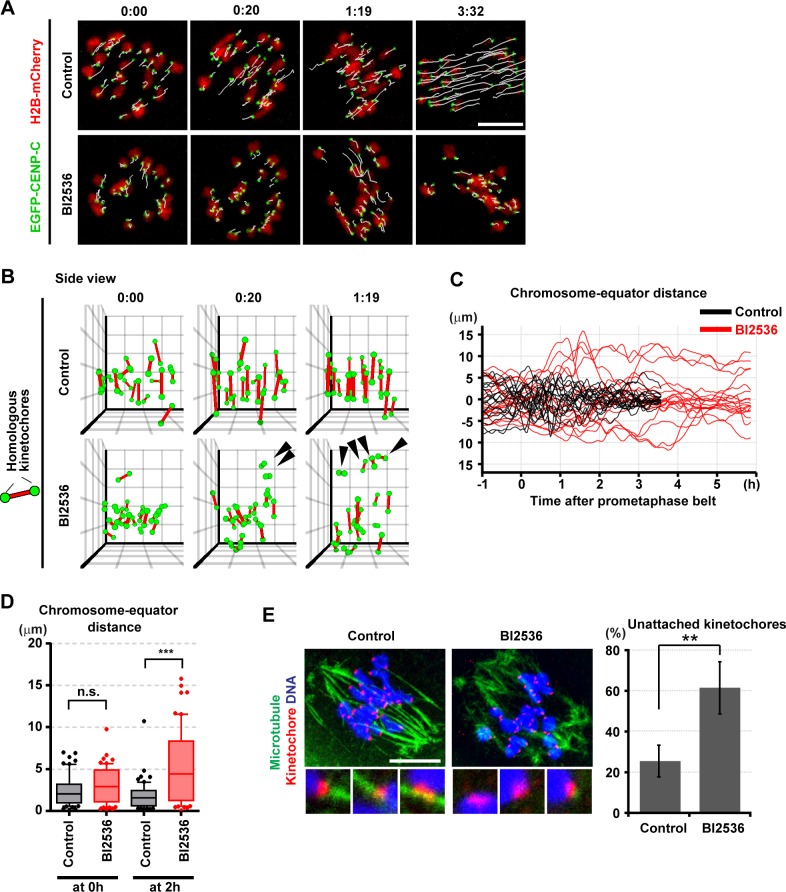
PLK1 is required for chromosome alignment.(A) Imaging of meiosis I in oocytes expressing EGFP-CENP-C (kinetochores, green) and H2B-mCherry (chromosomes, red) in the presence of DMSO (control) or 100 nM BI2536. Maximum intensity z-projection images are shown. White lines indicate kinetochore tracks over 5 timepoints. Time after NEBD (h:mm). Scale bar = 10 μm. Also see S4 Movie. (B) Kinetochore positions were determined from (A) and shown in the 3D plot as green spheres. Red bars connect homologous kinetochores. The view along the chromosome distribution equator (side view) is shown. Black arrowheads indicate misaligned chromosomes. Time after prometaphase belt formation (h:mm). The unit of the grid is 5 μm. (C) Chromosome positions along the estimated spindle axis were plotted for all twenty chromosomes of a single oocyte cultured in the presence of DMSO (control, black) or 100 nM BI2536 (red). (D) Distances between chromosomes and the equator at 0 and 2 hours after the prometaphase belt formation were potted. The box indicates 10–90 percentile (n = 60, 60, 60, 60 from three oocytes for each condition). ***p < 0.0001. (E) Oocytes 4 hours after NEBD were briefly treated with a cold buffer and fixed for immunostaining of microtubules (blue) and kinetochores (red). 100 nM BI2536 was added at 2 hours after NEBD. DNA was stained with Hoechst33342 (blue). Insets show magnified images of kinetochore-microtubule attachments. Scale bar = 10 μm. Average and s.d. of the population of unattached kinetochores are shown (n = 5, 5. **p < 0.01).